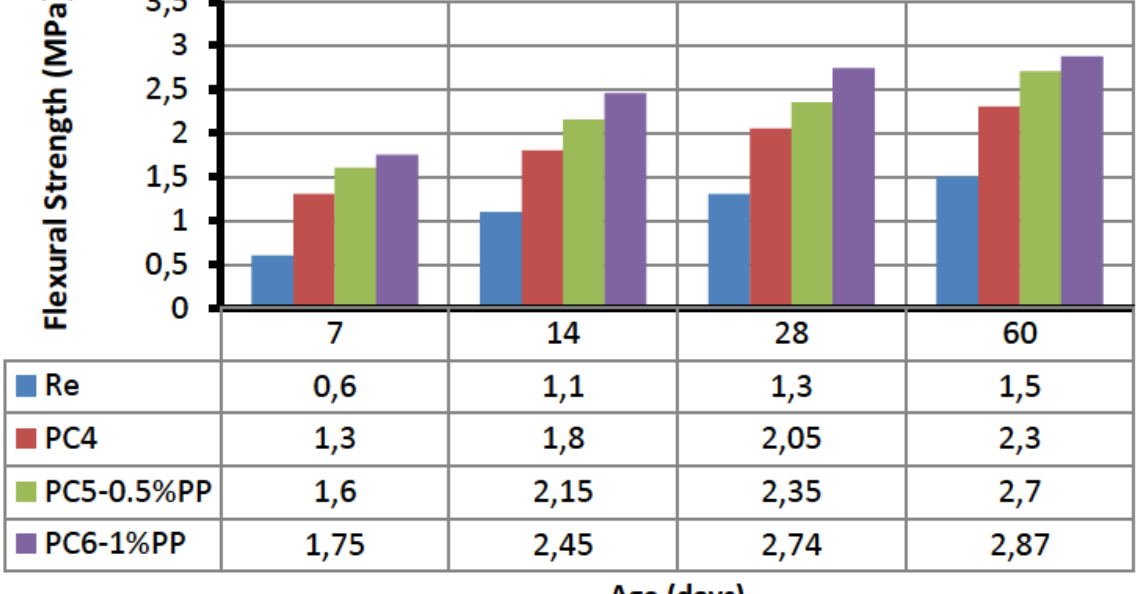
absorption rate in the cement paste was 2.978% due to the open voids in the structure of the cement paste. While the absorption rates for polymeric concrete specimens were zero for being solid and